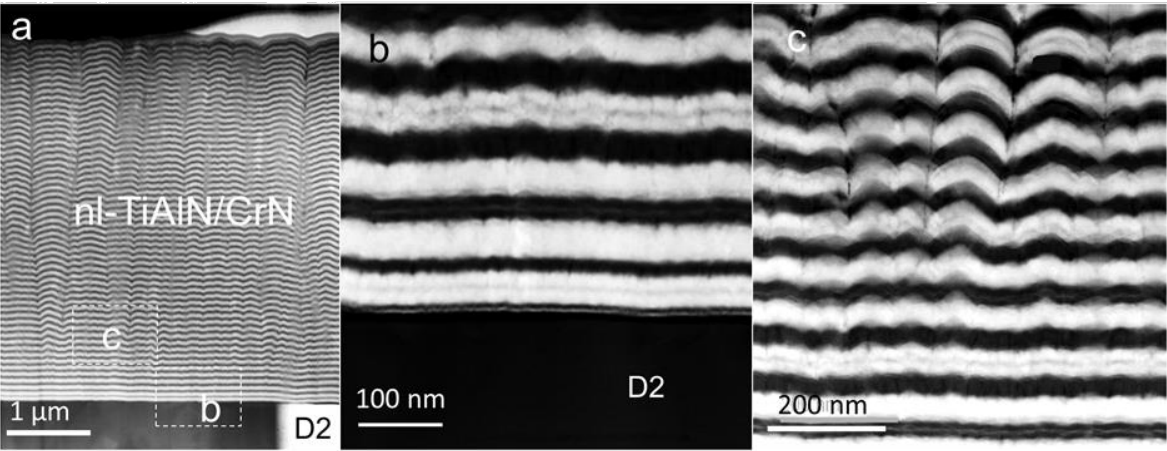
Figure 20. Bright-field STEM cross-sectional images of TiAlN/CrN nanolayered coating sputter deposited in CC7 deposited on D2 tool steel substrate ( a ). The roughness of the TiAlN/CrN interfaces gradually increases up to the top of the coating ( b , c ).